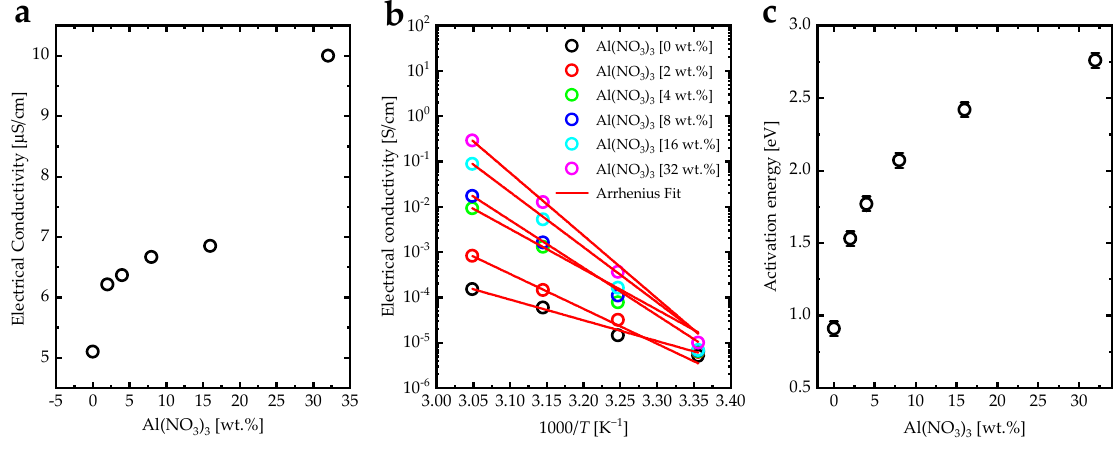
Figure 8. ( a ) Electrical conductivity vs. Al(NO 3 ) 3 concentration [wt.%], ( b ) electrical conductivity vs. 1000/T [K − 1 ], and ( c ) activation energy vs. Al(NO 3 ) 3 concentration [wt.%] for (PANI-HCl)/Al(NO 3 ) 3 complex composite films.